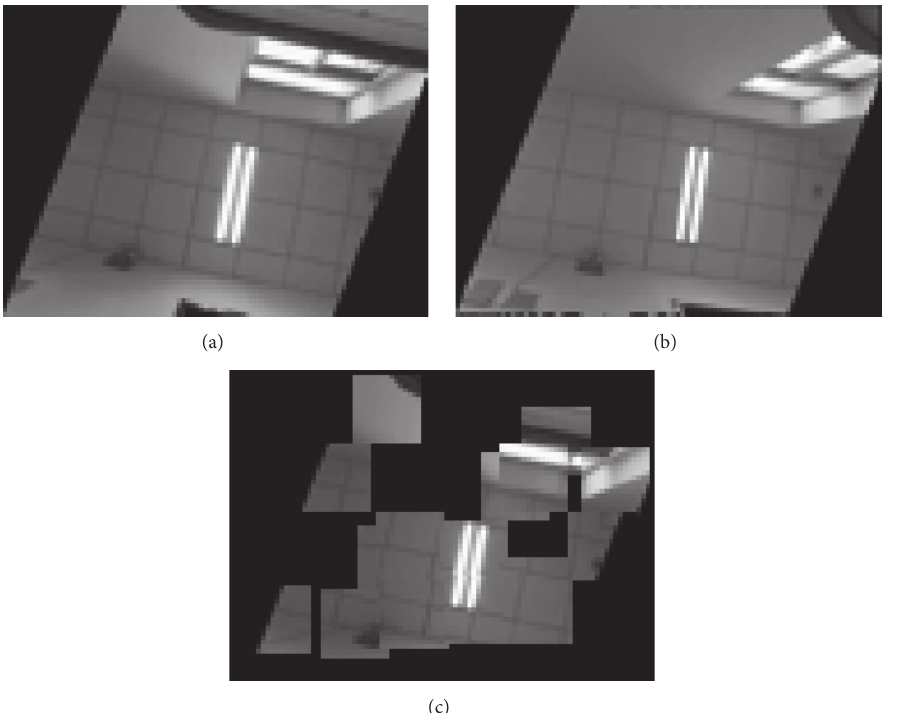
Figure 8: The rebuild overlap region by two similar frames. (a) The overlap region in frame 𝐴 , (b) the overlap region in frame 𝐵 , and (c) the rebuild overlap region in frame 𝐴 .